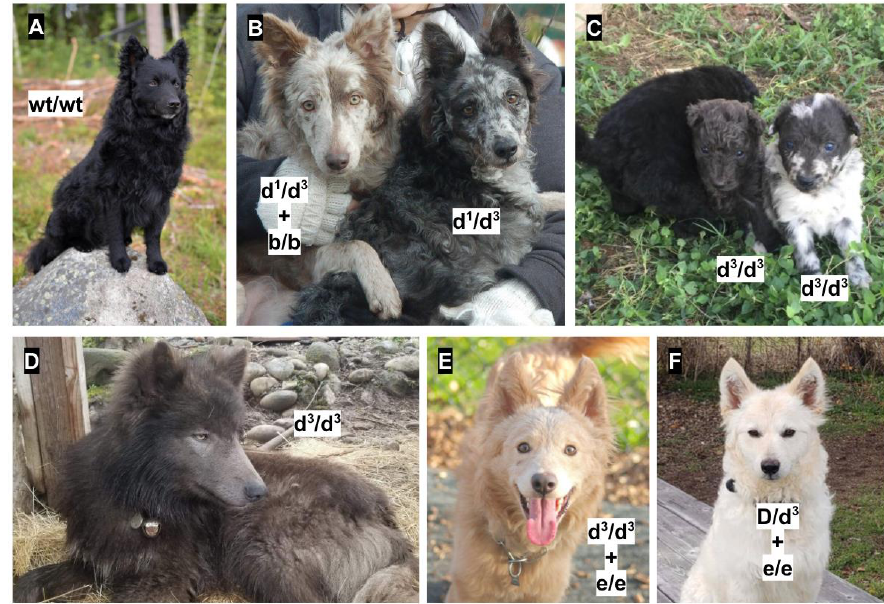
Figure 4. Hungarian mudi dogs and wolf-dog hybrids with a dilute coat color. A , a homozygous wild type mudi dog at d 1 , d 2 , and d 3 ; B , two mudi dogs that are both compound heterozygotes for d 1 and d 3 ; C , two mudi dogs homozygous for d 3 ; D , a d 3 homozygous wolf-dog hybrid; E , an e/e, d 3 homozygous mudi dog; F , an e/e, D/d 3 mudi dog.